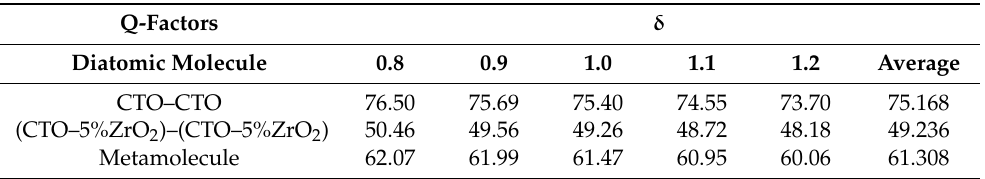
Table 1. Q-factors of CaTiO 3 (CTO) “homonuclear diatomic molecule”, CaTiO 3 with 5% ZrO 2 (CTO–5%ZrO 2 ) “homonuclear diatomic molecule”, and metamolecules with various distances δ and their average values of these distances. Table 2. Figure of merit (FoM) of CTO “homonuclear diatomic molecule”, CTO–5%ZrO 2 “homonuclear diatomic molecule”, and metamolecule with various distances 𝛿 and their average values of these distances. FoM